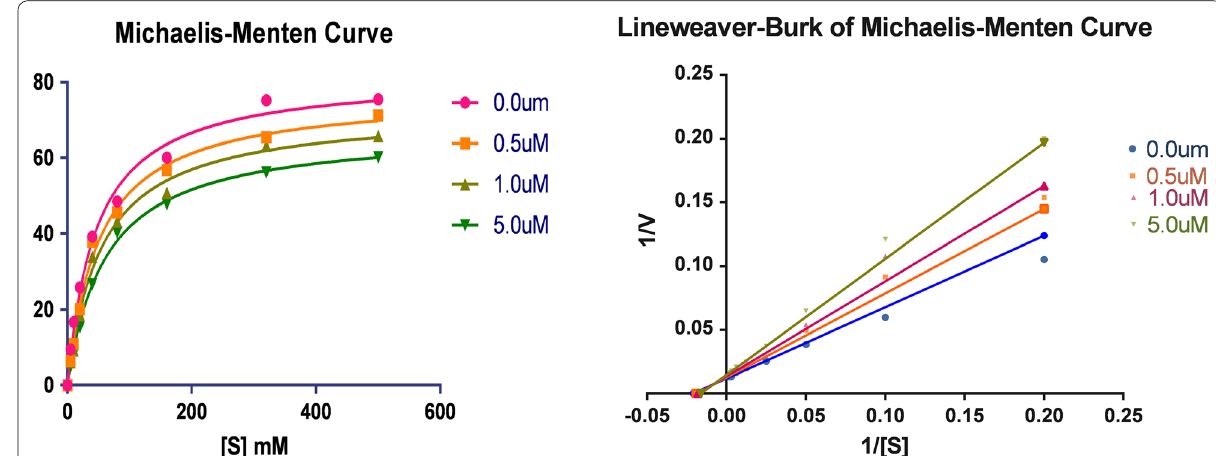
Fig. 5 Lineweaver–Burk plot for oxidation of tyramine by MAO-B in the presence and absence of compound 5